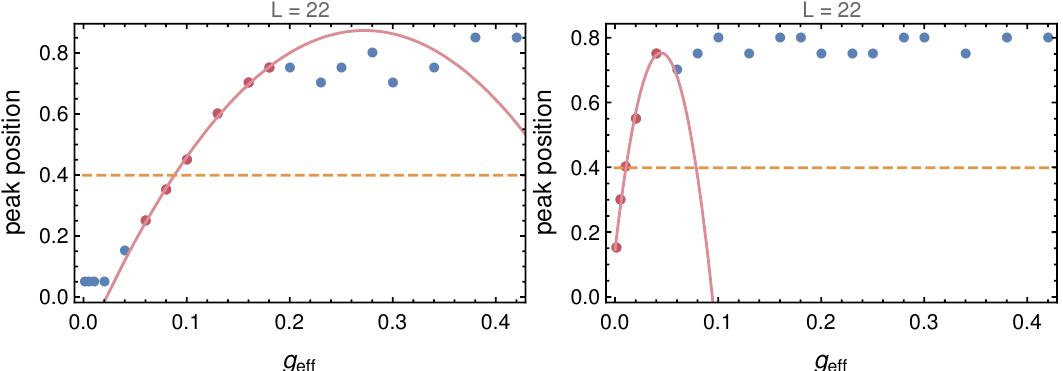
Figure 8: Obtaining g from the maximum positions for different effective couplings cr for J (left) and NNNI perturbation (right) in the gapless phase ( ∆ = 0.2). The red solid line is the parabola fitted to the red markers in the vicinity of x orange dashed